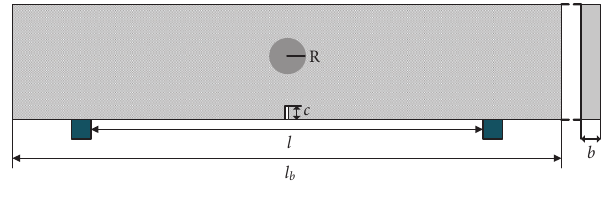
Figure 4: The numerical model.